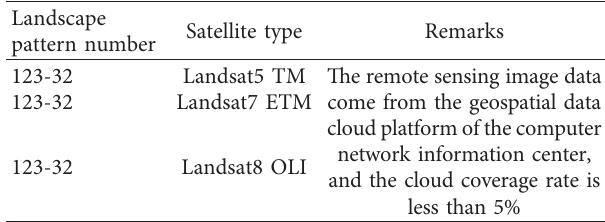
Figure 1: Structure diagram of ecological urban landscape pattern. Table 1: Remote sensing image sources.